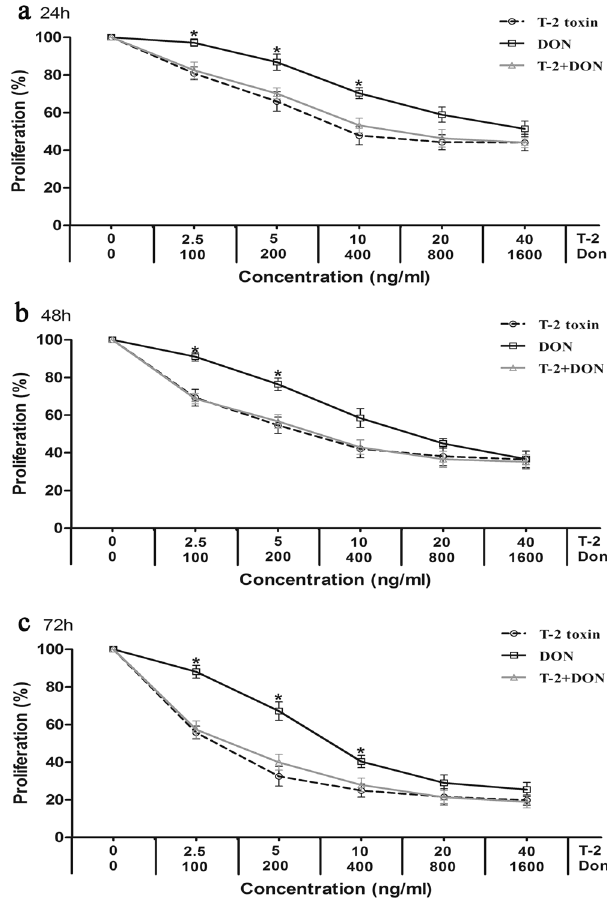
Figure 2. Cytotoxicity T-2 toxin and/or DON in the liver-derived cell line, L-02. Cells were exposed to mycotoxins for ( a ) 24 h, ( b ) 48 h and ( c ) 72 h and analyzed by the MTT method, as described in Fig. 1. Each data point represents the mean ± SEM from three independent experiments with replicate samples, * p < 0.05 indicates significant differences between the mixture and T-2 toxin alone, # p < 0.05 represents significant differences between the mixture and DON